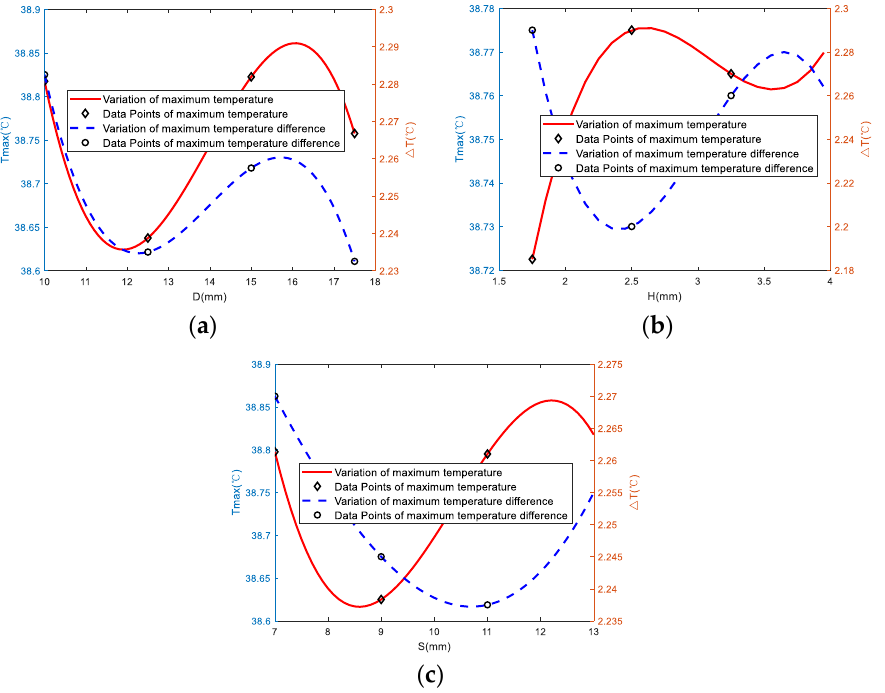
Figure 10 . ( a ) Curve of the effect of D on 𝑇 𝑚𝑎𝑥 and Δ 𝑇 𝑚𝑎𝑥 ( b ) Curve of the effect of H on 𝑇 𝑚𝑎𝑥 and Figure 10. ( a ) Curve of the effect of D on T max and ∆ T max ( b ) Curve of the effect of H on T max and Δ 𝑇 𝑚𝑎𝑥 ( c ) Curve of the effect of S on 𝑇 𝑚𝑎𝑥 and Δ 𝑇 𝑚𝑎𝑥 . ∆ T ∆ T max ( c ) Curve of the effect of S on T max and max